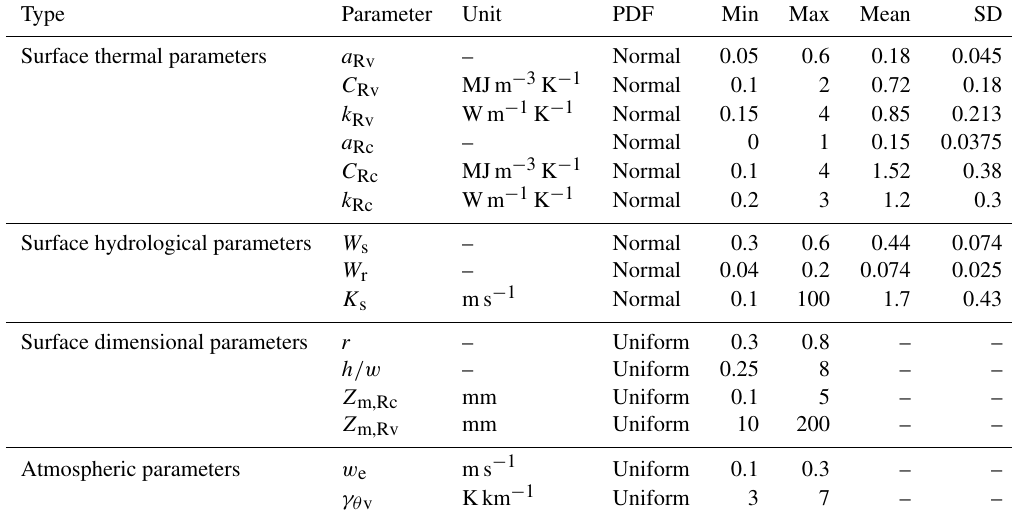
Table 2. Summary of statistics of uncertain parameters used in the sensitivity study. Type